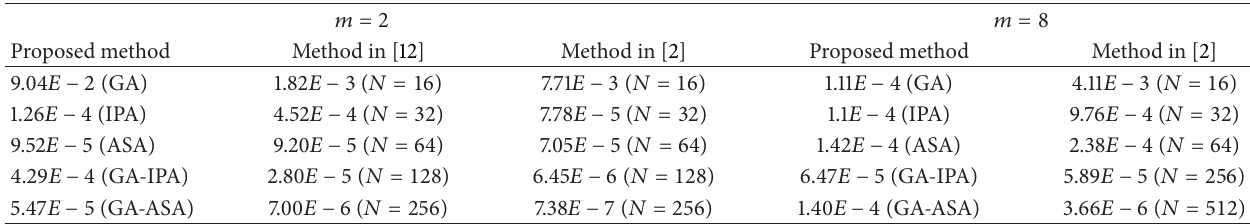
Table 8: Comparison of maximum absolute errors in solution of Example 2 between the proposed heuristic computing method and the methods given in [2, 12] (for 𝑚 = 2 ,